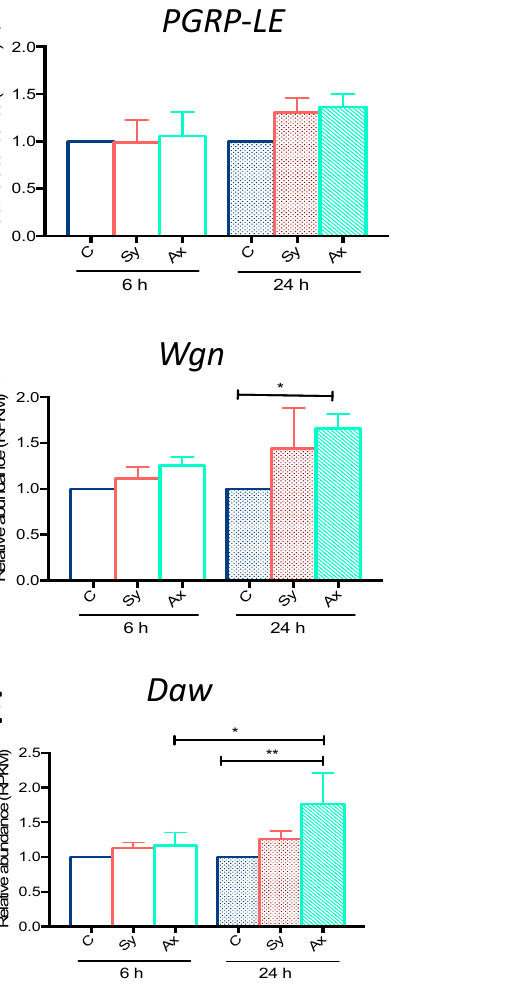
Figure 1. Relative gene transcript levels obtained using RNA-sequencing analyses on Drosophila melanogaster larvae infected with Steinernema carpocapsae symbiotic or axenic nematodes [7]. Relative transcript (Reads Per Kilobase Million; RPKM) levels of ( A ) PGRP-LE ; ( B ) MyD88 ; ( C ) Wengen ( Wgn ); ( D ) Domeless ( Dome ); ( E ) Dawdle ( Daw ); and ( F ) Decapentaplegic ( Dpp ) were estimated in D. melanogaster larvae (Oregon strain) infected with 100 symbiotic (Sy) or axenic (Ax) S. carpocapsae nematodes at 6 and 24 h post-infection. Treatment with water served as control ( C ). Relative abundance was estimated as a ratio compared to the uninfected control larvae at 6 and 24 h post-treatment. Values represent means from three biological replicates and error bars represent standard deviations. Data were analyzed using one-way analysis of variance (ANOVA) and a Tukey post-hoc test for multiple comparisons using GraphPad Prism 7 software. * p < 0.05, ** p < 0.01, *** p < 0.001. Non-significant differences ( p > 0.05) are not shown.